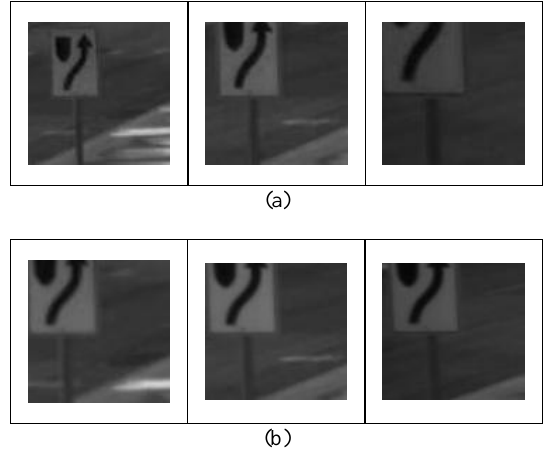
Figure 3. An example of road sign image back projection: (a) the original images and (b) back-projected images of vertical pseudo patch, in which the scale differences between images are reduced. For most of the road surface images, the results of back projection to a horizontal pseudo plane can reduce the viewing angle variations. Fig. 4(a) shows an example of 3 original images of a road surface, and Fig. 4(b) shows the results of back projection from a horizontal pseudo plane. The results indicate that the viewing angle variations are reduced by back-projection.